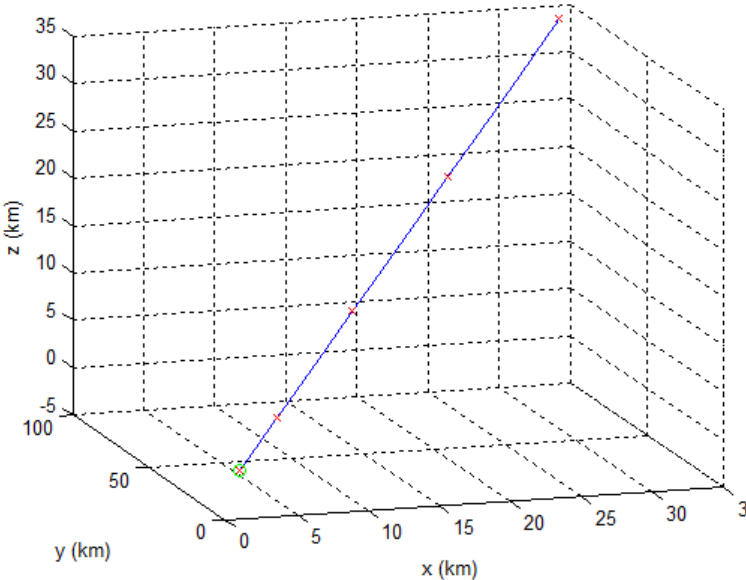
Figure 5. Baseline trajectory in the orbital frame ( ε = 2